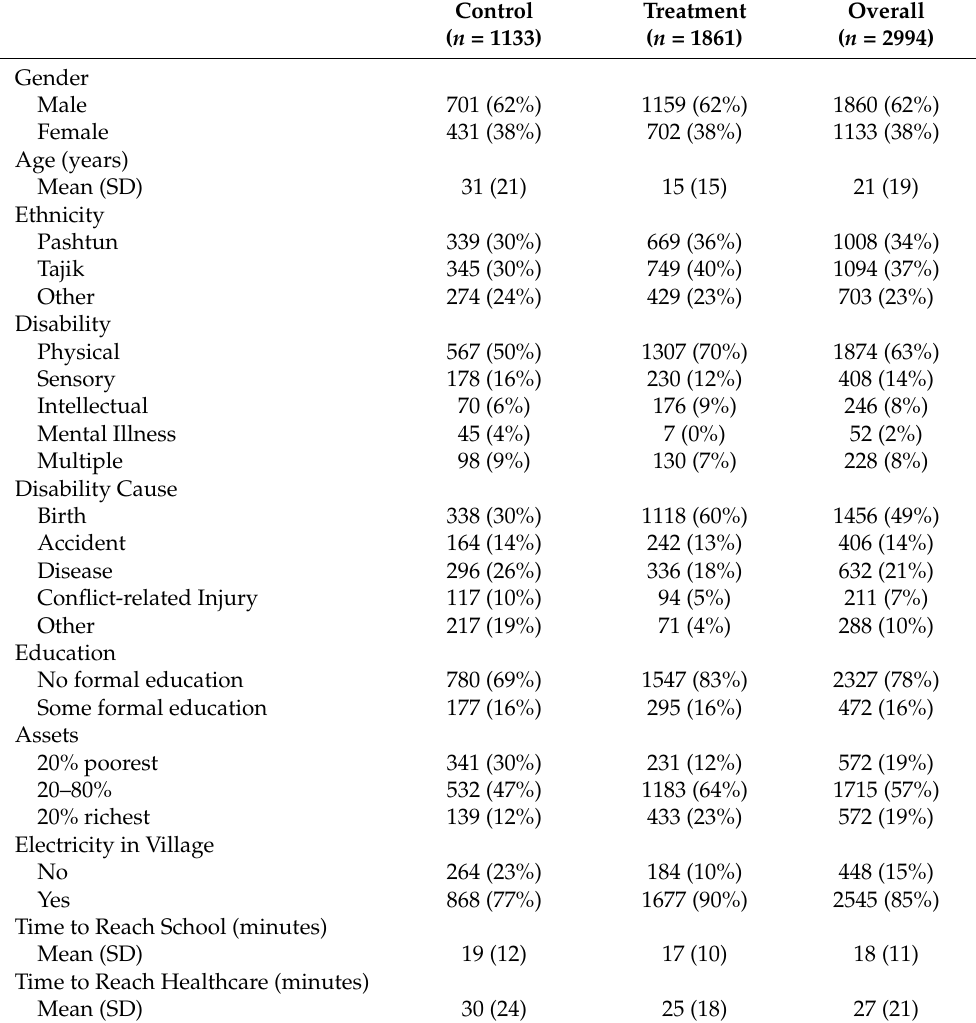
Table 1. Baseline study sample characteristics.